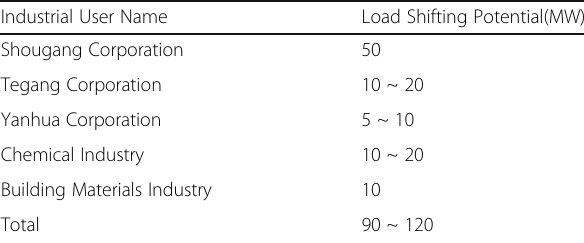
Table 2 Load shifting potential analysis of industrial users